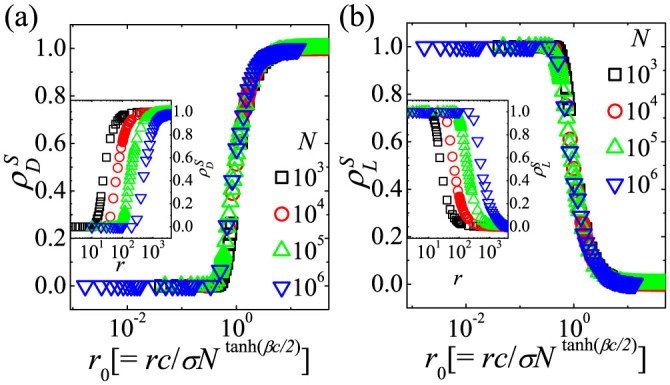
Simulation results of the SEPGG on the CG for various r and N.Plots of (a)  and (b)  against  for N = 103, 104, 105, and 106. c = 1, σ = 1, and β = 1 are used. Inset of (a): Plots of  against r. Inset of (b): Plots of  against r.